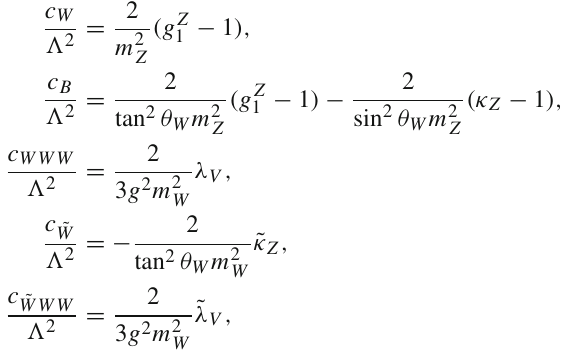
( inner bar ) and total ( outer bar ) measurement uncertainties are shown, as well as ratios of the theoretical predictions to the data (the bottom panel in each